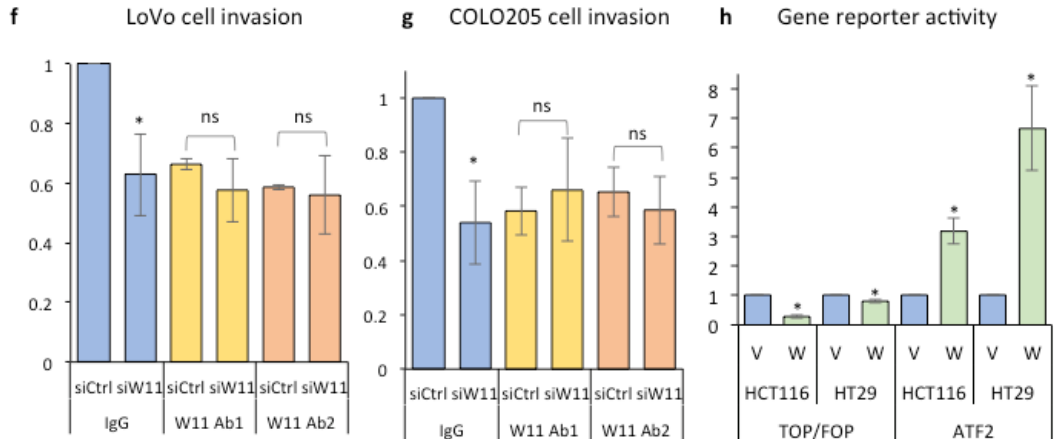
Figure 5. Wnt-11 expression and activity in CRC cell lines ( a ) q-RT-PCR for WNT11 mRNA in the indicated cell lines, showing average relative expression, normalized to COLO 205 cells; ( b ) cell extracts were probed with goat anti-Wnt-11 antibody and anti-HSP60 as loading control; arrowhead indicates position of Wnt-11, graph shows densitometry analysis; ( c , d ) relative invasion of LoVo cells ( c ) or COLO 205 cells ( d ) treated 24 h with 100 nM Wnt-C59 or vehicle (DMSO) ( c ) or 2 ug / mL rat anti-Wnt-11 (W11 Ab1 / 2) or rat IgG ( c , d ), n = 3, + p < 0.05 versus DMSO (Student’s t -test), * p < 0.05 versus IgG (ANOVA and Student’s t -test); ( e ) cell number normalized to control, after treatment with 2 ug / mL rat IgG or anti-Wnt-11 (W11 Ab1 / 2) for 5 days; ( f , g ) relative invasion of LoVo cells ( f ) and COLO 205 cells ( g ) transfected with control siRNA (siCtrl) or WNT11 siRNA (siW11) before plating for invasion and antibody treatment, n = 3, * p < 0.05 versus IgG siCtrl, ns, not significant; ( h ) relative activity of the indicated gene reporters in cells transfected with empty vector (V) or Wnt-11 plasmid (W) for 24 h, n = 3, * p < 0.05 versus empty vector (Student’s t -test).